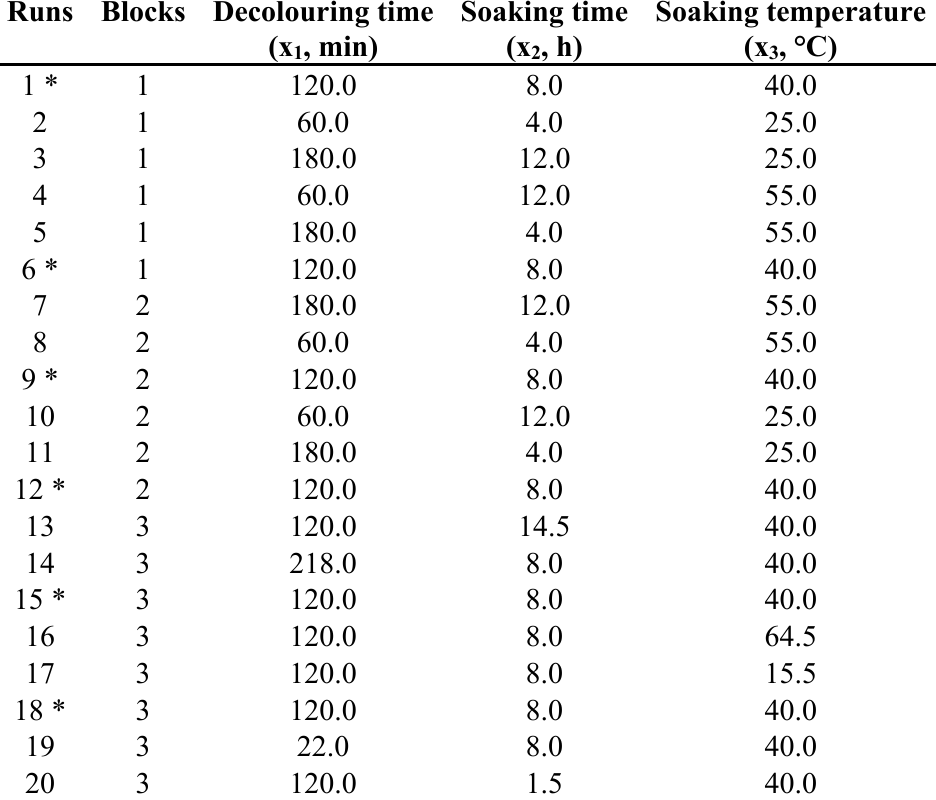
Table 3. Matrix of the central composite design (CCD) for chemical